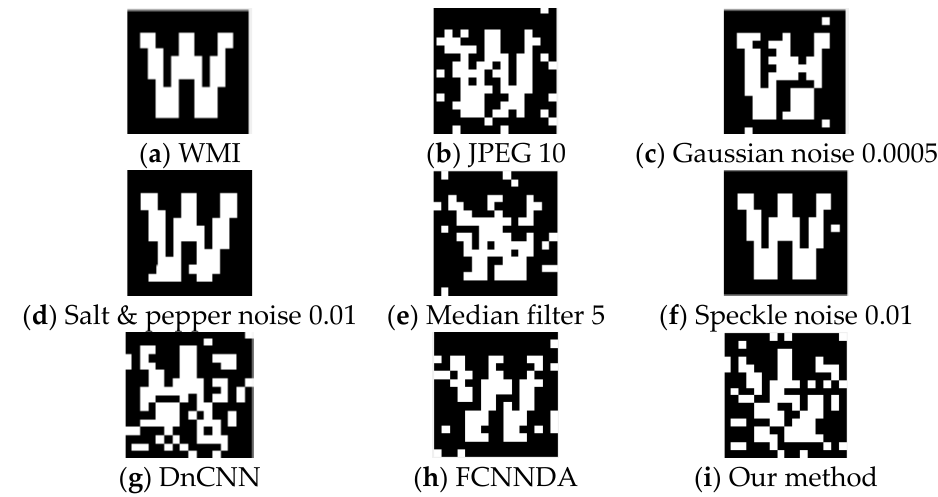
Figure 4. The image watermark extracted from the AWMI; the watermark size is 16 × 16. Compared to the images following the previous attacks, the distortion degree caused by the rotation attack is the greatest. However, the effect on the image watermark is minimal. This is due to the PHFMs’ rotational